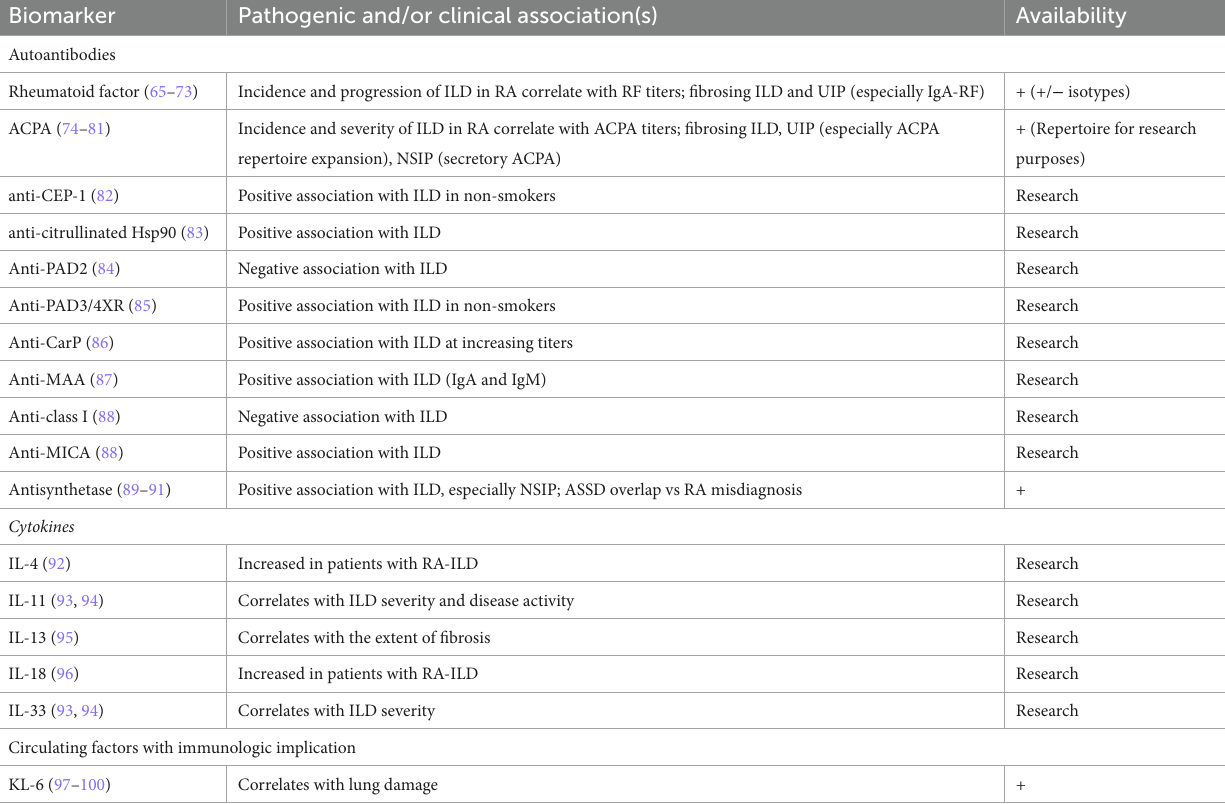
TABLE 2 Established and candidate biomarkers for RA-ILD; the proposed mechanistic links and setting of use are specified for all markers.